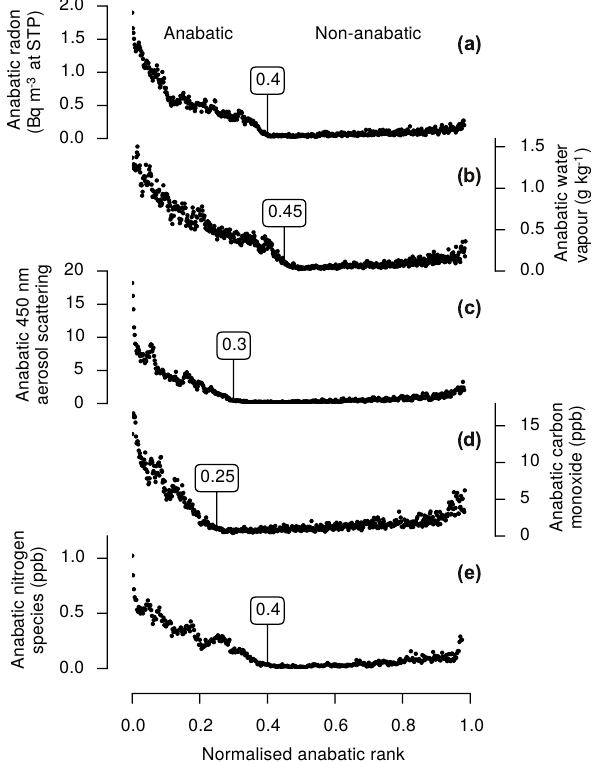
Figure 8. The anabatic contribution, meaning the daily mean con- centration due to anabatic flows, of several tracers as functions of the anabatic rank normalised by total number of observation days. The minimum in the anabatic concentration marks the boundary be- tween anabatic days, with lower anabatic rank, and non-anabatic